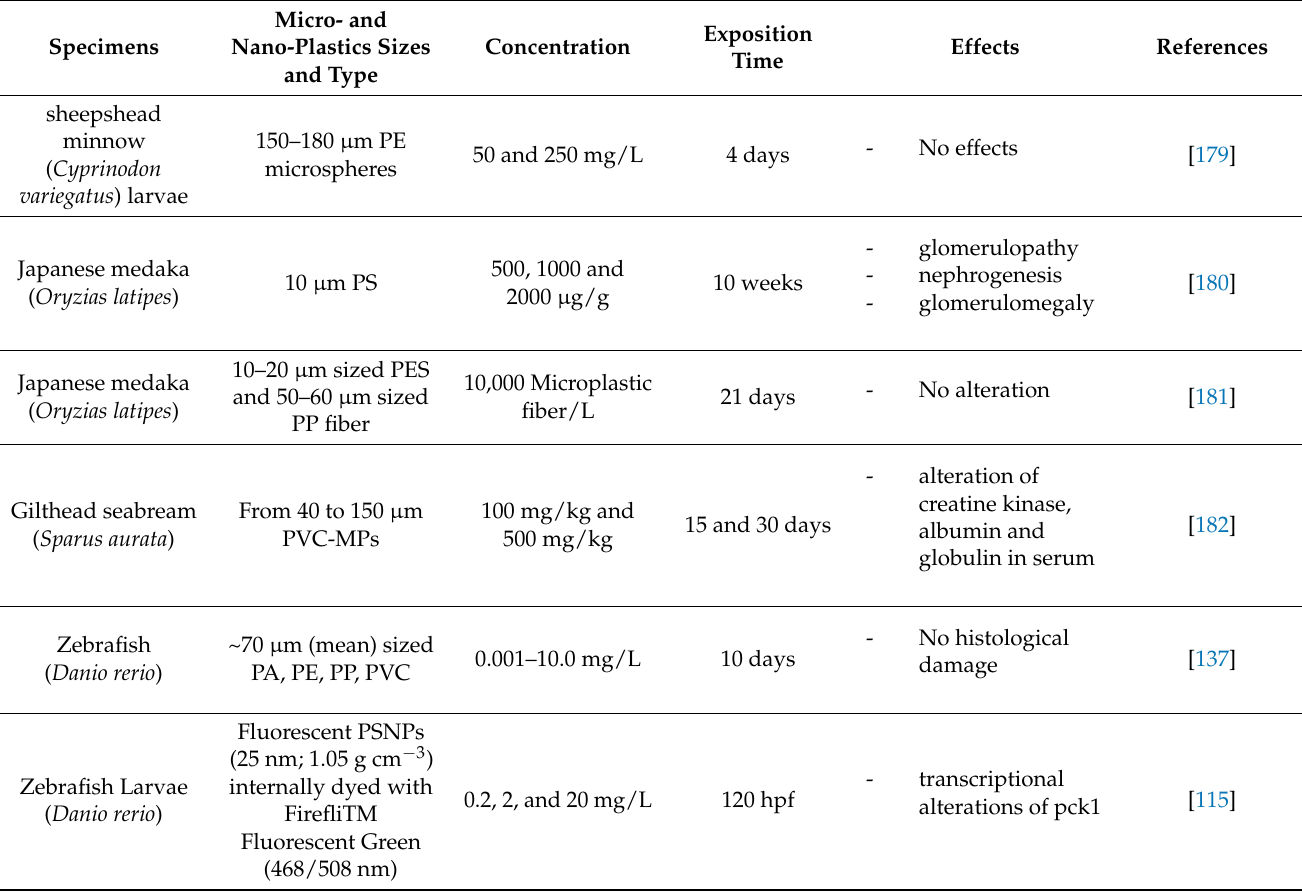
Table abbreviations. PVC-MPs: polyvinylchloride microparticles, polystyrene (PS), polyester (PES), polypropylene (PP), polyamides (PA), polyethylene (PE), polypropylene (PP), polyvinyl chloride (PVC), polystyrene nanoplastic